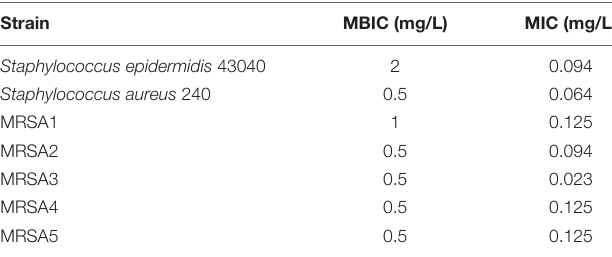
TABLE 1 | Comparison between dalbavancin MBICs at 20 h of growth, as determined by impedance measurements, and MICs measured by standard E -test.